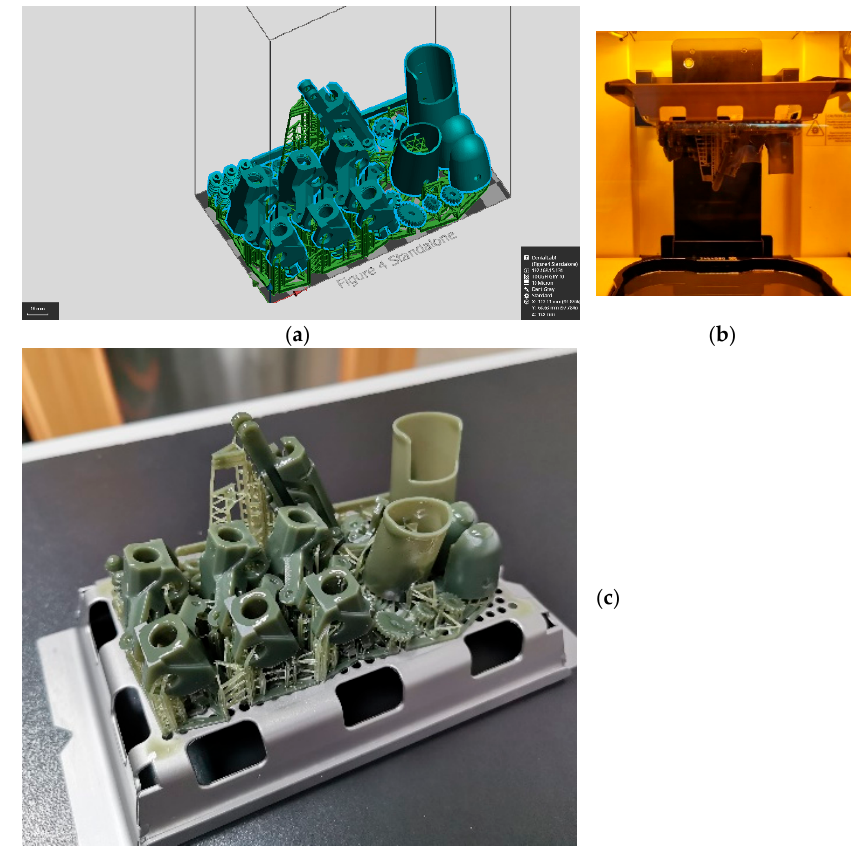
Figure 22. Print job finished for mechanical components. ( a ) Build table optimized for 3D print, ( b ) print job finished, ( c ) build platform before alcohol part wash.